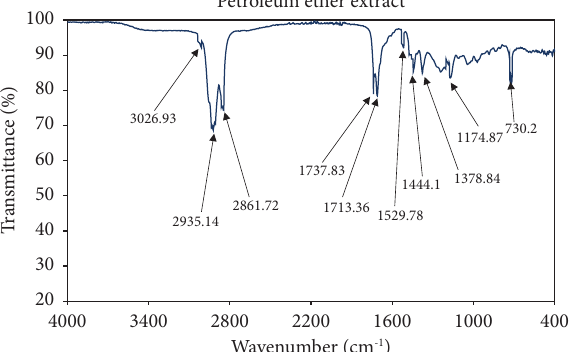
Figure 11: FTIR spectrum of fraction B from the ethanol extract of C. nioroense .